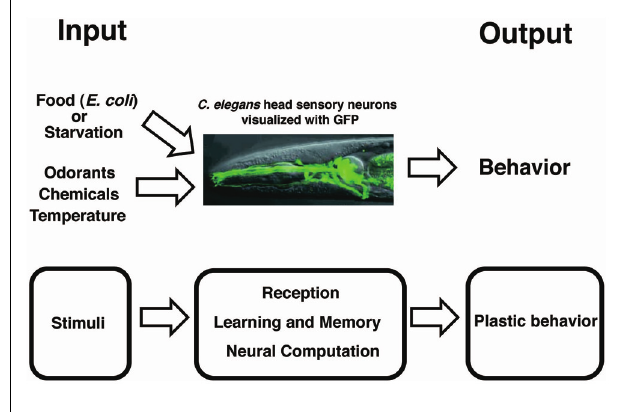
FIGURE 1 | Conceptual scheme for plastic behavior.